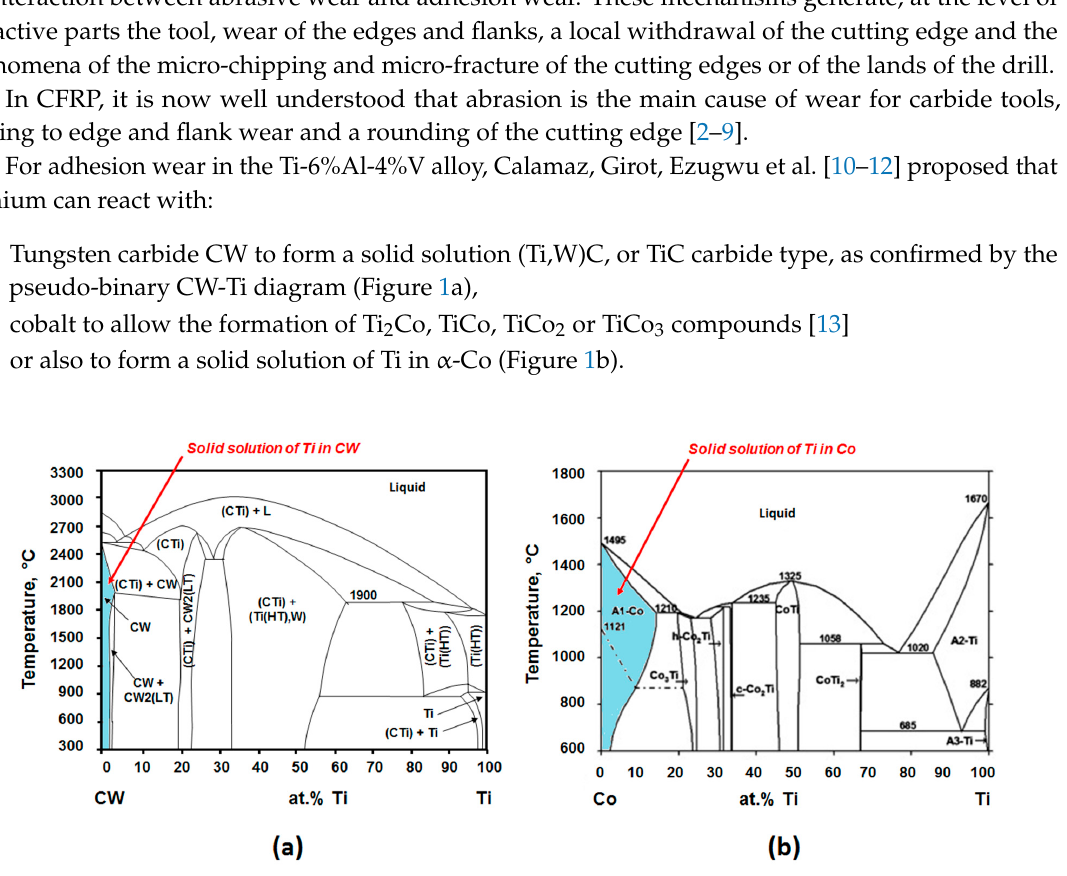
Figure 1. ( a ) Pseudo-binary diagram Ti/CW; ( b ) Binary diagram Ti/Co.